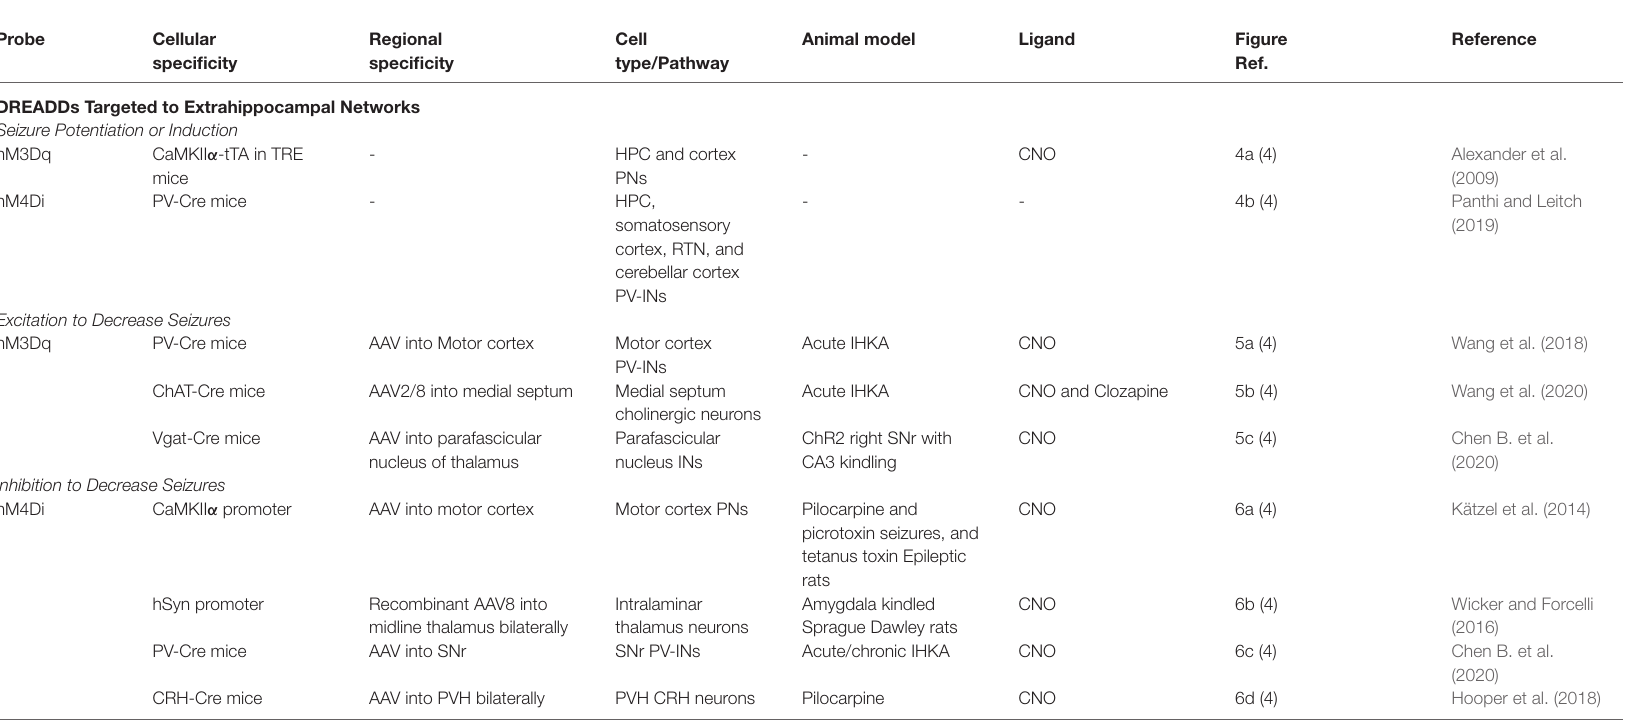
Table 1 reflects the structure of the sections on hippocampal and extrahippocampal networks. For each article, we listed DREADDs construct, how cellular and regional specificity was controlled, target cell type, neuronal pathway investigated, animal model employed and citation for the publication. The figure reference column contains a key to hippocampal and extrahippocampal networks depicted in Figures 3 , 4 , respectively. For example, a figure reference of 1 refers to publications that used DREADDs to potentiate or induce seizures by targeting networks within the HPC and has a 3 in parenthesis because it is depicted in Figure 3 . Publications that targeted similar cells or networks have the same alphabetical designation in the figure reference column. The cellular specificity column includes the viral promoter if it was used to drive cellular specificity rather than Cre driver mouse lines. AAV, adeno associated virus; CA, Cornu Ammonis; CaMKII, calcium/calmodulin-dependent protein kinase II; ChAT, choline acetyl-transferase; ChR2, channelrhodopsin-2; CNO, clozapine-N-oxide; CRH, corticotropin-releasing hormone; DG, dentate gyrus; DGC, dentate granule cells; DrD2, dopamine receptor D2; DREADDs, designer receptors exclusively activated by designer drugs; eDGC, ectopic dentate granule cell; ER, estrogen receptor; hM3Dq, G q -coupled human M3 muscarinic DREADD; hM4Di, G i -coupled human M4 muscarinic DREADD; HPC, hippocampus; hSyn, human synapsin 1; IHKA, intrahippocampal kainic acid; INs, interneurons; IPKA, intraperitoneal kainic acid; PN, pyramidal neuron; POMC, proopiomelanocortin; PV, parvalbumin; PVH, paraventricular hypothalamic nucleus; RTN, reticular thalamic nucleus; RV, retrovirus; SNr, Substantia nigra; SOM, somatostatin; Sub, subiculum; TA, temporoammonic; TAM, tamoxifen; TRE, tet response element; tTa, tet transactivator; Vgat; vesicular GABA